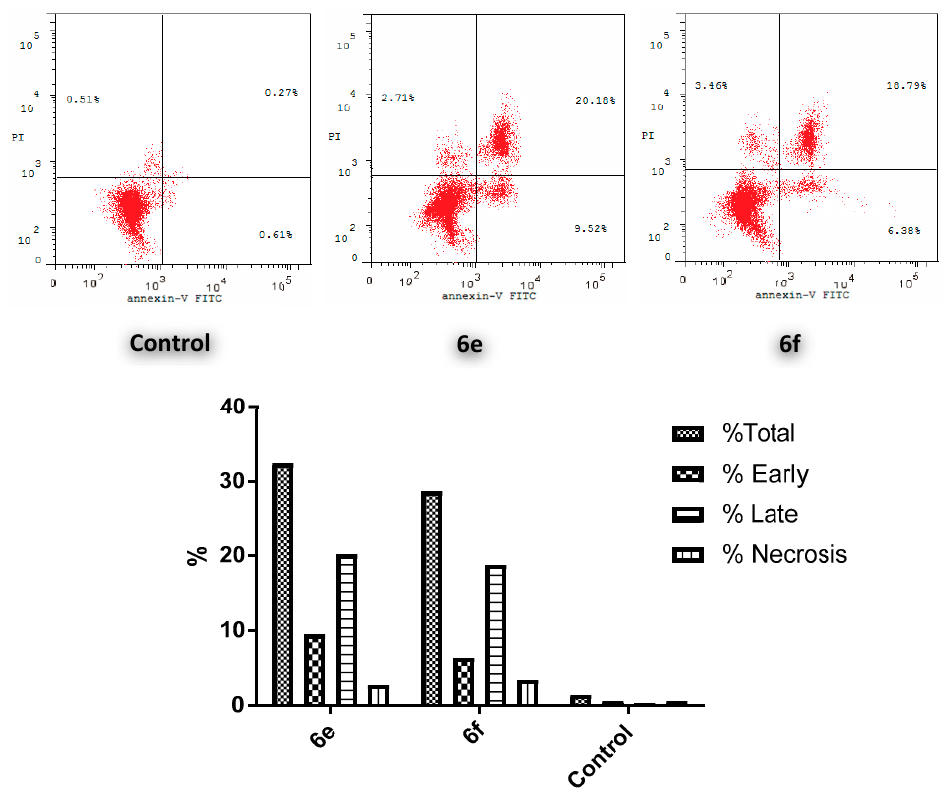
Figure 4. Influence of 6e and 6f on the percentage of annexin V-FITC-positive staining in MCF-7